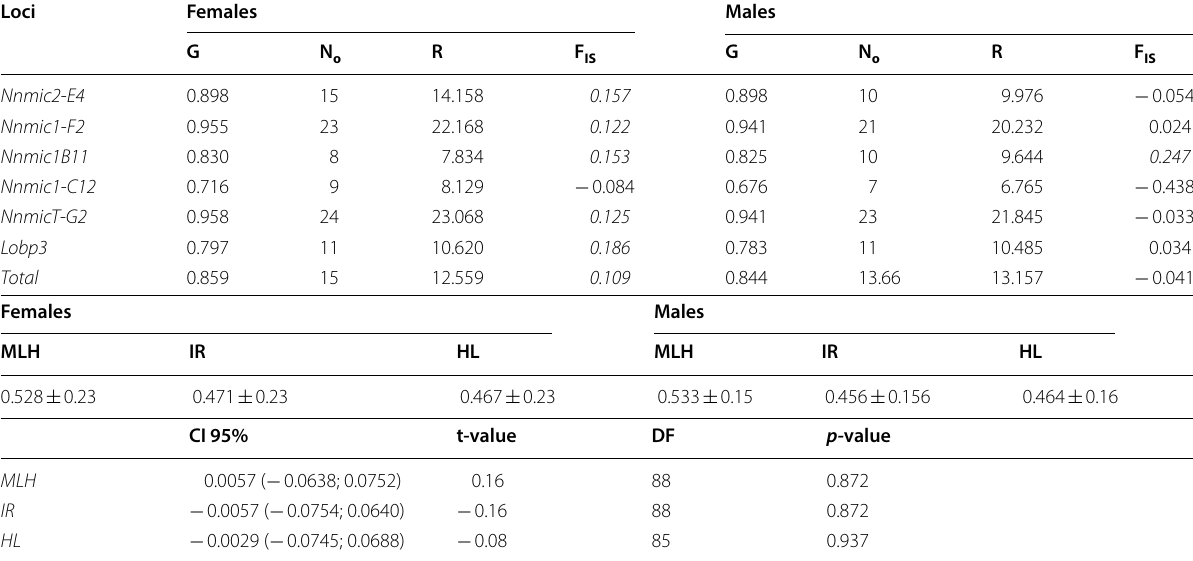
Mean values of MLH, IR and HL for both sexes along with confidence intervals (CI) values of t test; significances are in italics